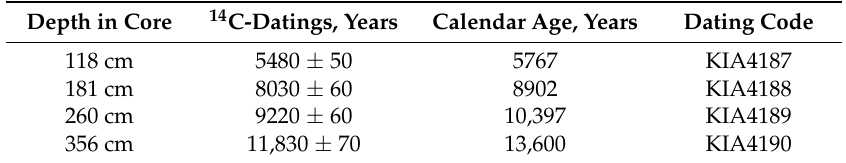
Table 1. List of the accelerator mass spectrometer 14 C-datings of the absolute age of the sediment core AMK-340. Conversion of 14 C-datings to the calendar ages was made according